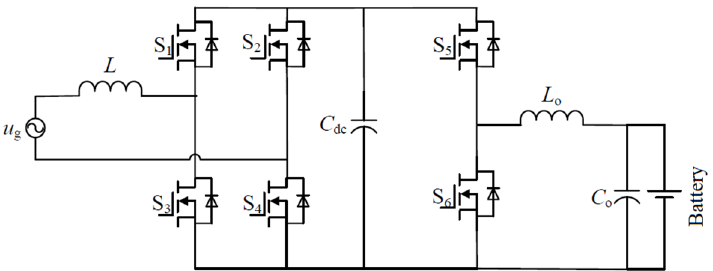
Figure 13. Non-isolated charging topology with PWM (pulse width modulation) and bidirectional buck–boost DC/DC converter.